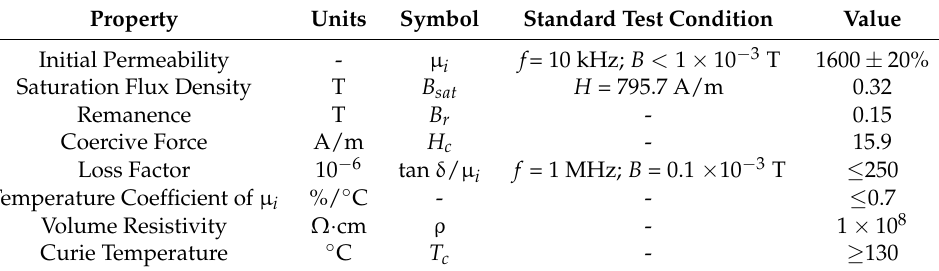
Table 1. Properties of the NiFeZn Soft Magnetic Powder * [25].